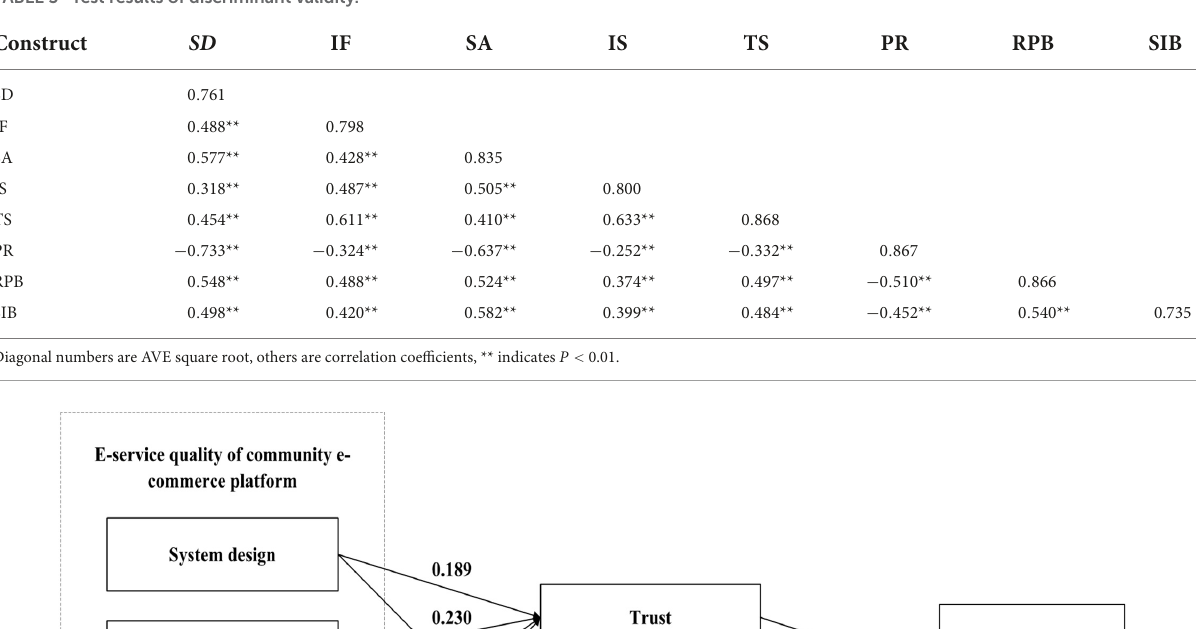
TABLE 3 Test results of discriminant validity.